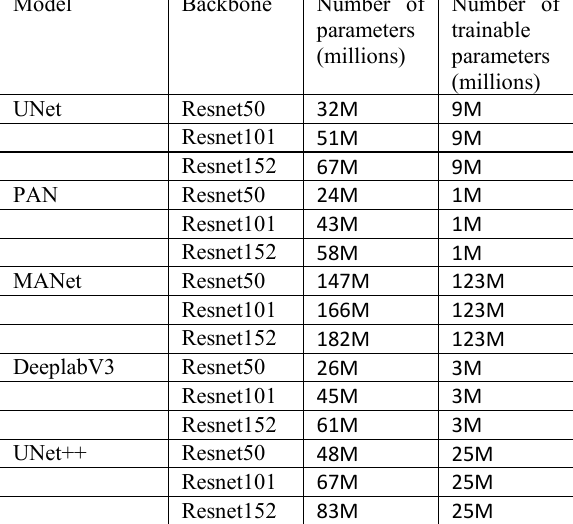
Table 1. Comparison of the size variation of candidate DL-CNN models